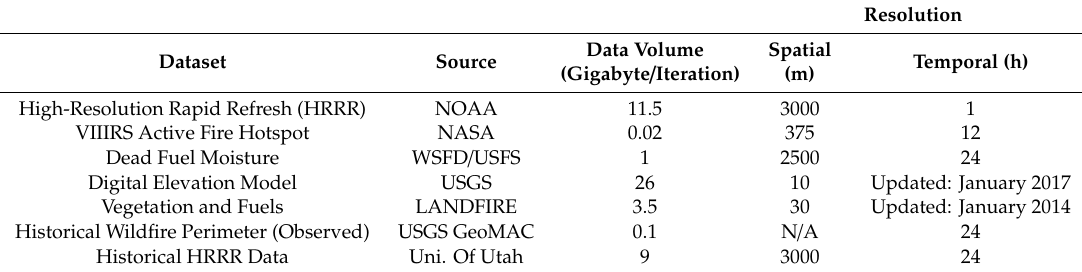
Table 1. Metadata of datasets used to simulate wildfire events, adapted from Adhikari et al.